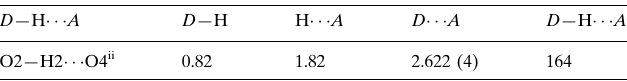
Hydrogen-bond geometry (A˚ , (cid:3)